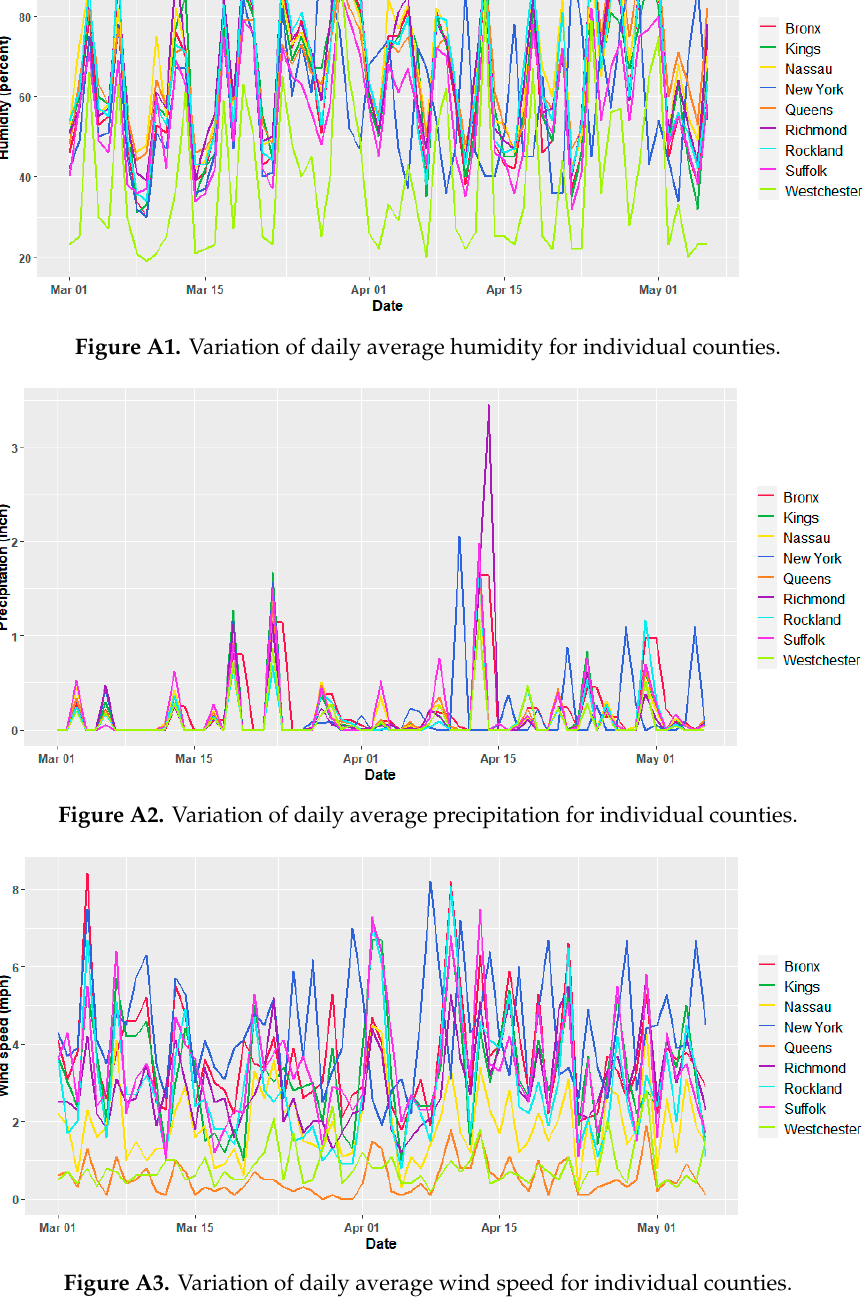
Figure A4 . Scatter plots for the number of daily COVID-19 new cases vs. PM 2.5 (in μ g/m 3 ) represented in natural logarithmic values for individual counties.